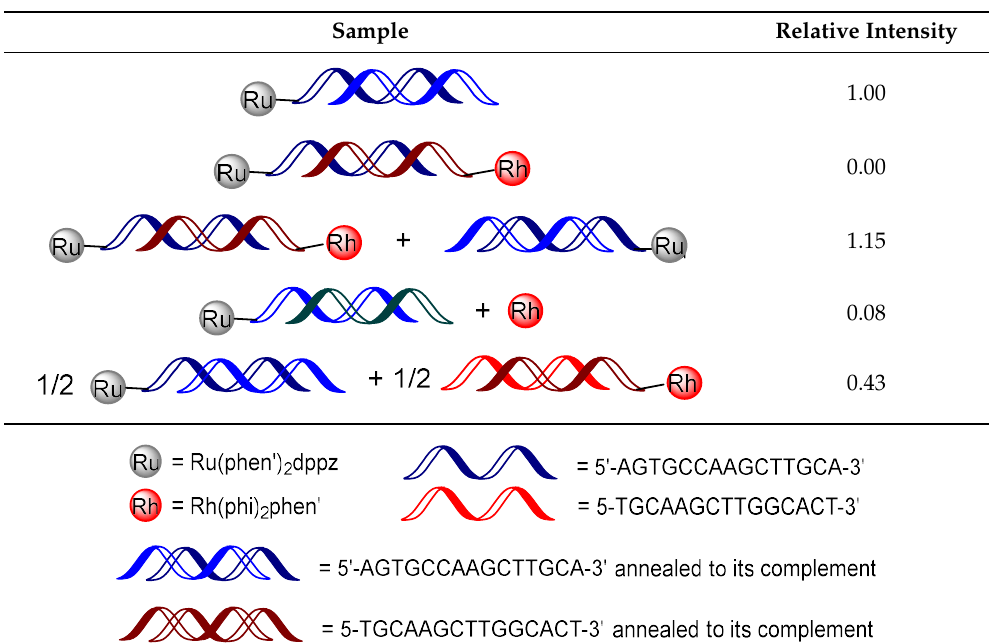
Table 1. Luminescent intensity of intramolecular metal-DNA complexes relative to that of